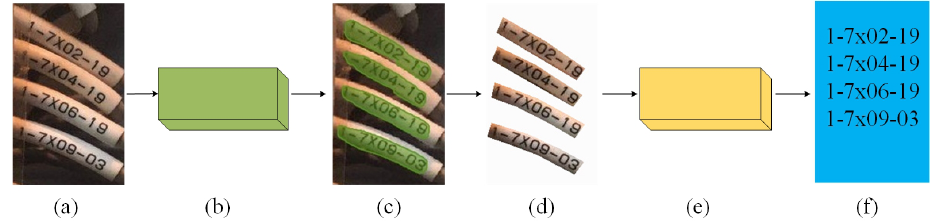
Figure 2. The overall architecture of Rwin-FPN++. ( a ) is the input image with dense scene text. ( b ) is the Rwin Transformer-based feature pyramid network. ( c ) is the result of text detection. ( d ) is the result of text segmentation. ( e ) is the convolutional recurrent neural network to recognize each segmentation region. ( f ) is the final spotting